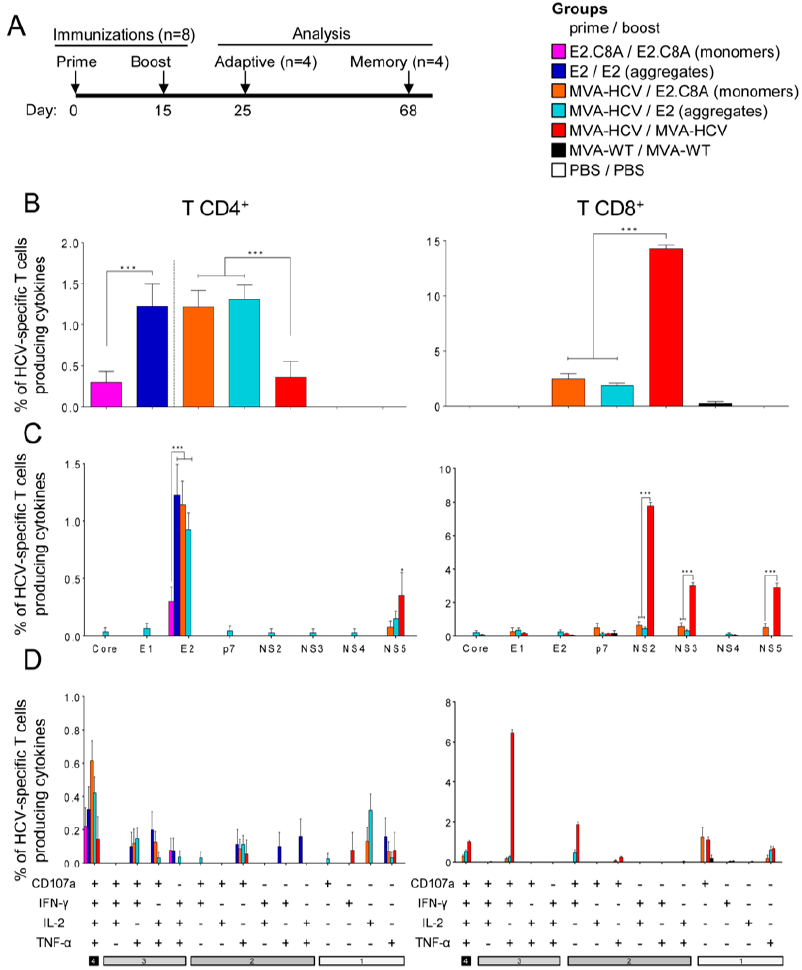
Figure 4. Adaptive CD4 + and CD8 + HCV-specific T cell immune responses in immunized mice. ( A ) Mouse immunization schedule. Eight C57BL / 6 mice were immunized with E2 proteins, MVA-HCV, MVA-WT, or PBS at days 0 and 15. At day 25, serum was taken from each mouse for analyzing humoral responses (see Figures 7 and 8), after which half of the mice were sacrificed to analyze T cellular immune responses in the adaptive phase. At day 68, the remaining four mice were sacrificed for analyzing responses in the memory phase. ( B ) Magnitude of the total HCV-specific CD4 + and CD8 + T cell responses after stimulation of splenocytes with the di ff erent HCV peptide pools. The total value in each group represents the sum of the percentages of CD4 + and CD8 + T cells secreting CD107a and / or IFN- γ and / or IL-2 and / or TNF- α against HCV antigens. Dashed line separates groups stimulated only with E2 peptide pools (left) from groups stimulated against all HCV antigens (right). ( C ) Breadth of the HCV-specific T cell response shown as the percentage of cells secreting CD107a and / or IFN- γ and / or IL-2 and / or TNF- α against each HCV peptide pool. ( D ) Polyfunctionality of the HCV-specific T cell response shown as the combined production of CD107a and / or IFN- γ and / or IL-2 and / or TNF- α against all HCV peptide pools. p values indicate significant response di ff erences between immunization groups (*** p <